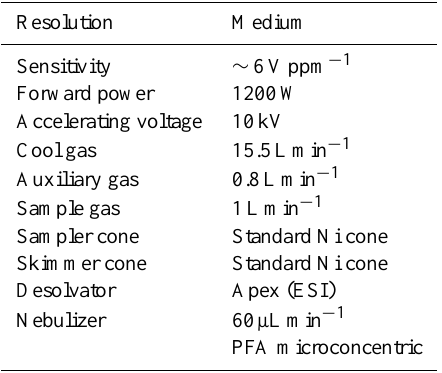
Table 1. Operating conditions for the Neptune